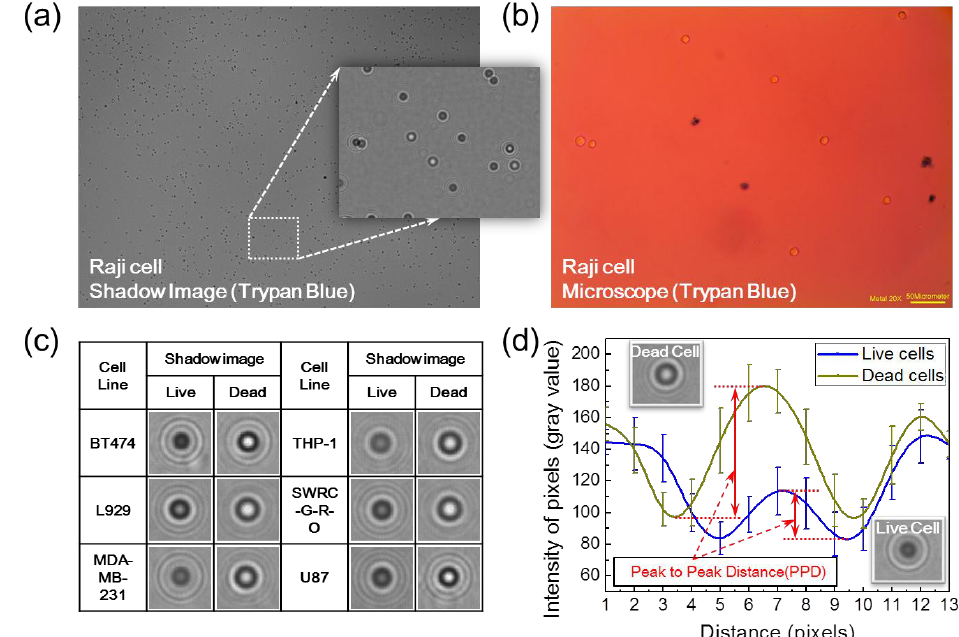
Figure 5. Principle of viability analysis without reagent. ( a ) Lens-free shadow image of stained Raji cells; ( b ) Corresponding microscope image of ( a ); ( c ) Live and dead cell shadow images of six cell lines (BT474, L929, MDA-MB-231, THP-1, SWRC-G-R-O and U87) without staining; ( d ) The PPD is